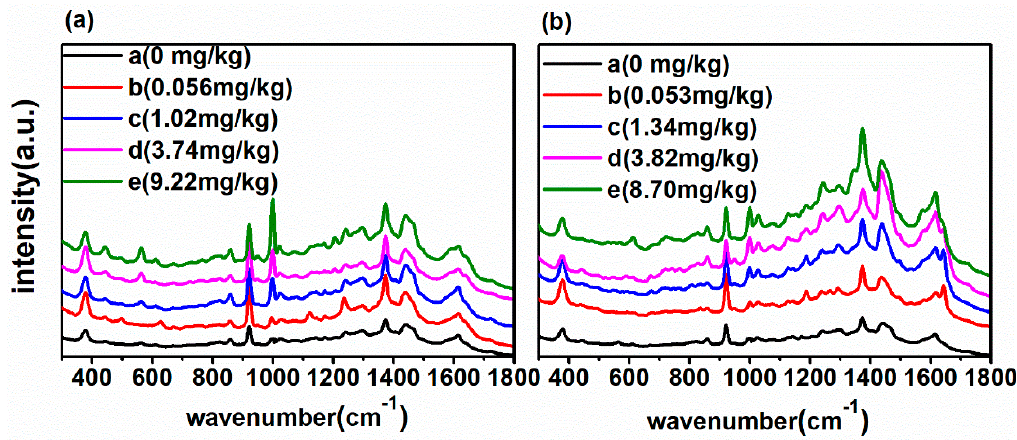
Figure 5. ( a ) The SERS spectra of DM in soil at the concentration of 0, 0.056, 1.02, 3.74 and 9.22 mg/kg; ( b ) the SERS spectra of CBF in soil at the concentration of 0, 0.053, 1.34, 3.82 and 8.70 mg/kg.